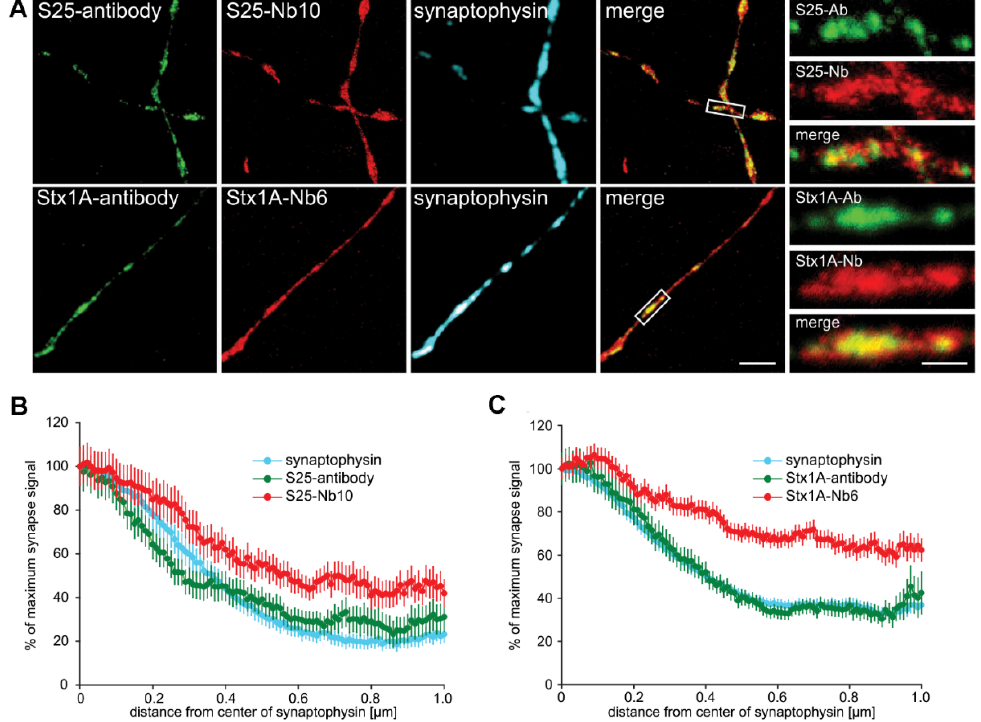
Figure 4. Typical antibody-induced artefacts in synaptic imaging. ( A ), The exocytosis SNARE proteins SNAP25 and syntaxin1A were imaged using stimulated emission depletion microscopy (STED) microscopy in cultured hippocampal neurons, relying on antibodies (green) or nanobodies (red). Synapses are indicated by a conventional antibody immunostaining for the synaptic vesicle marker synaptophysin (blue). Both the overview images and the insets give the impression that the antibodies form large spots or clusters, while the nanobodies provide a smoother pattern. Scale bars: 2 µm (left panels) and 0.5 µm (right panels). ( B ), ( C ) An analysis of the signal patterning, in terms of signal loss in relation to the center of the synapses revealed that the antibodies indeed formed large clusters, mostly in synapses, while the nanobodies also detected the molecules elsewhere. Reproduced from